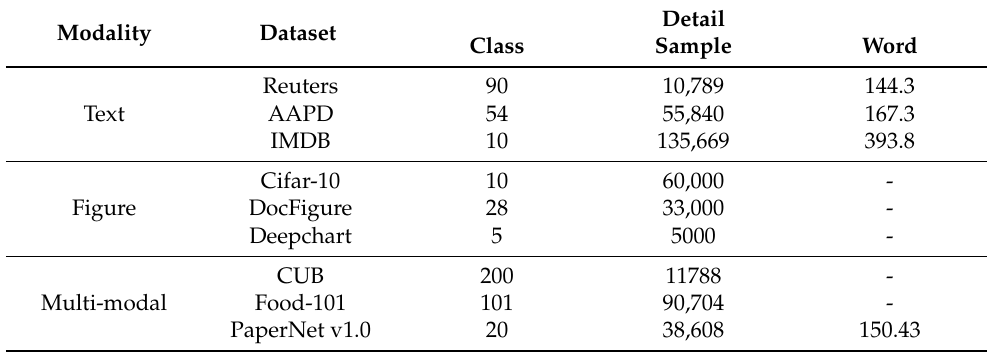
Table 1. The details of related